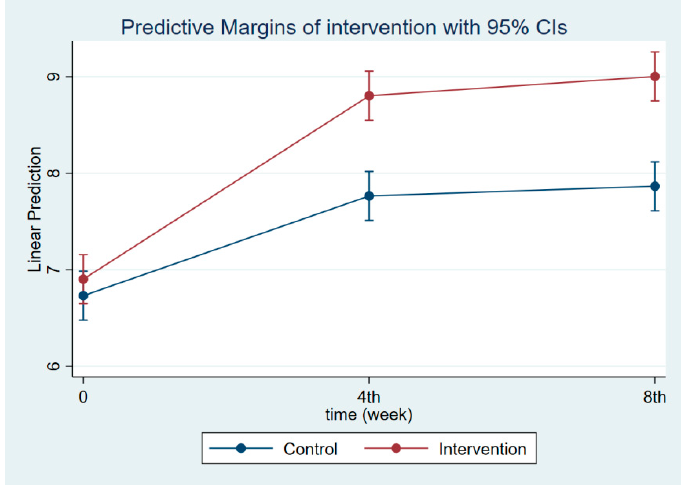
Figure 3. Maternal knowledge regarding CDM at follow-ups 1 and 2.